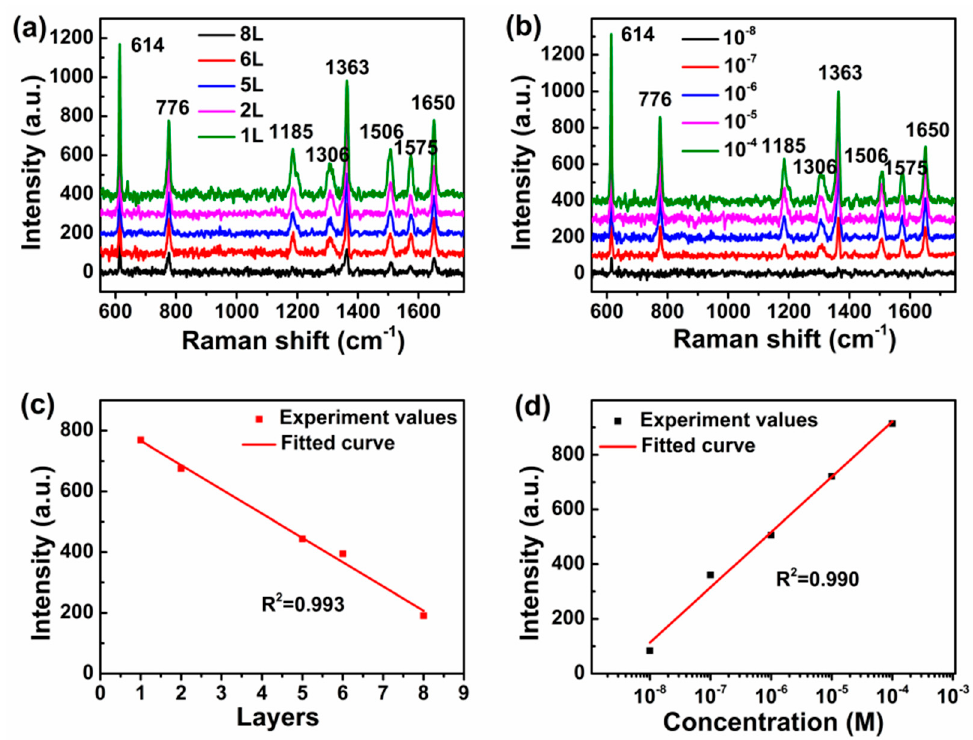
Figure 5. ( a ) Surface-enhanced Raman spectroscopy (SERS) spectra of 1 × 10 − 4 M Rhodamine 6G (R6G) molecule absorbed on different thickness SnSe 2 nanoflakes; ( b ) SERS spectra of R6G with concentration from 10 − 4 to 10 − 8 M on monolayer SnSe 2 nanoflakes; ( c ) The SERS intensity at 614 cm − 1 of R6G as a function of the thickness of SnSe 2 nanoflakes; ( d ) The intensity of SERS peak at 614 cm − 1 of R6G changes as a function of the molecular concentration on the SnSe 2 /mica substrate. Laser wavelength: 532 nm; power: 0.5 mw; lens: 100 × objective; acquisition time: 8 s.